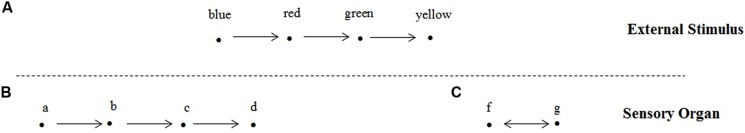
This figure illustrates different representational capacities of sensory organs. (A) represents a light source emitting different colors. The sensory organ illustrated in (B) is capable of associating the series of different states a,b,c,d where each state is related to a different color blue, red, green, and yellow. (C) illustrate another kind of sensory organ not capable of distinguishing blue from green and red from yellow and, therefore, representing the changes occurring in the exterior world by simplified set of states (f,g).